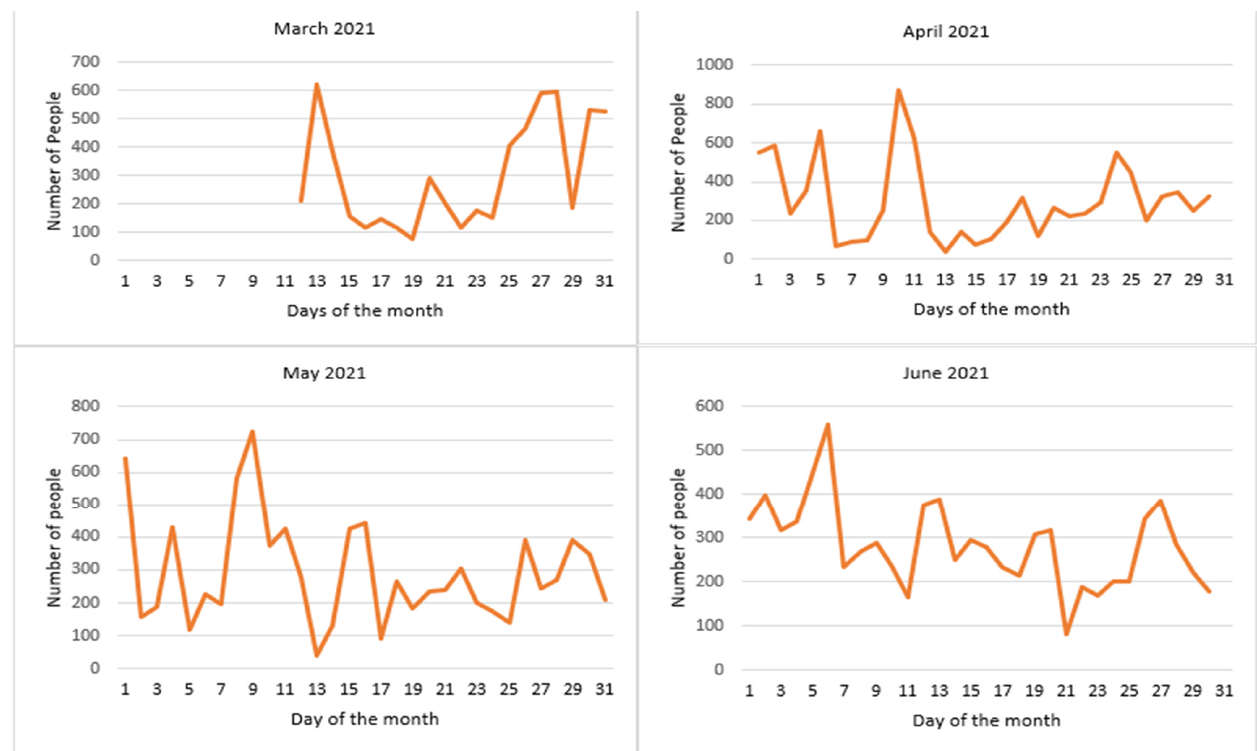
Figure 4. Recorded number of visitors per day in given months together in 2021.